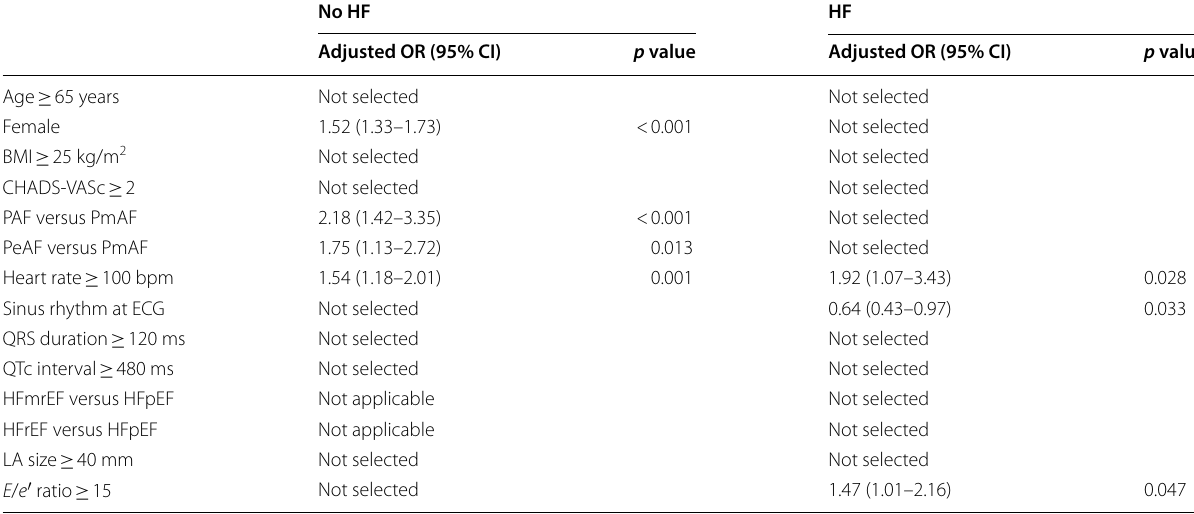
Table 3 Deterministic factors related to symptoms according to the presence of heart failure in atrial